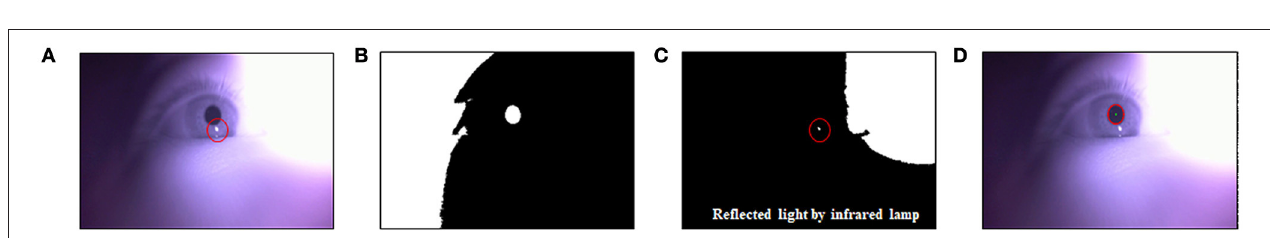
FIGURE 3 | Protocol for measuring the pupil area. (A) A gray-scale image from the infrared web-cam. (B) Binarization image based on auto threshold. (C) Detecting the reflected light caused by the infrared lamp. (D) Calculating pupil position using a circular edge detection